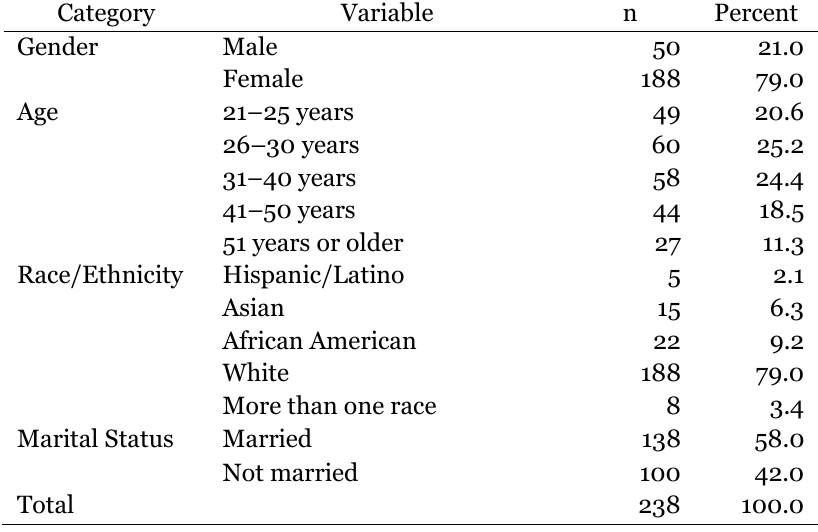
Demographics of Student